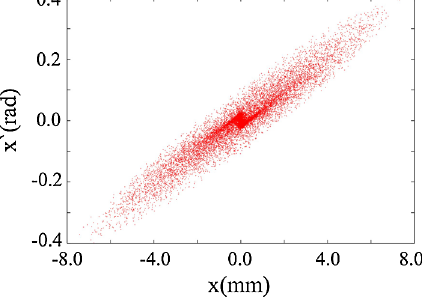
FIG. 15. Proton distribution x - x 0 for the energy band 10 MeV (cid:2) 0 : 5 MeV after 460 ps. The local influence of elec- trons comoving on the axis is seen at j x j < 0 : 5 mm .